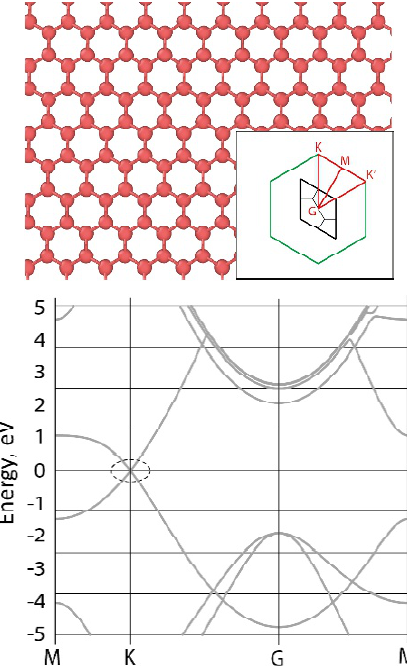
Fig. 1. Graphene crystal and its band structure. In the inset for graphene crystal schematics, Brillouin zone is shown. Dirac cone is outlined by a dashed ellipse.